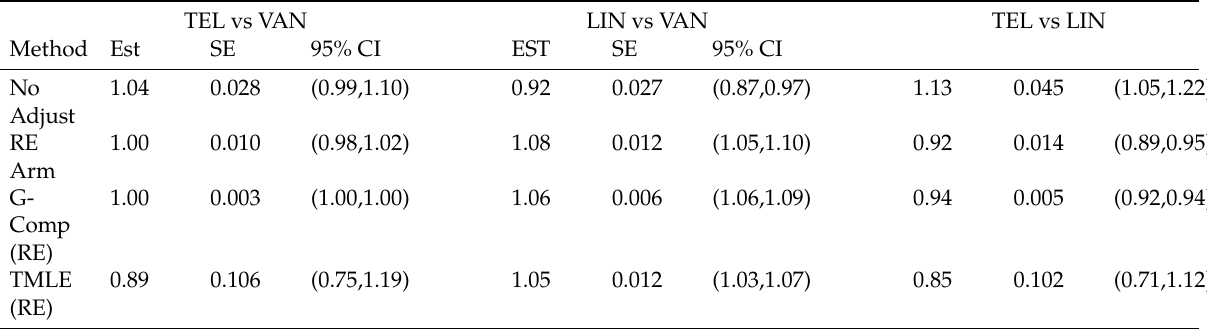
Table 4: Risk ratio estimates, standard errors and 95% confidence intervals for relative effects of antibiotics telavancin (TEL), linezolid (LIN), and mainstay therapy vancomycin (VAN) TEL vs VAN LIN vs VAN TEL vs LIN Method Est